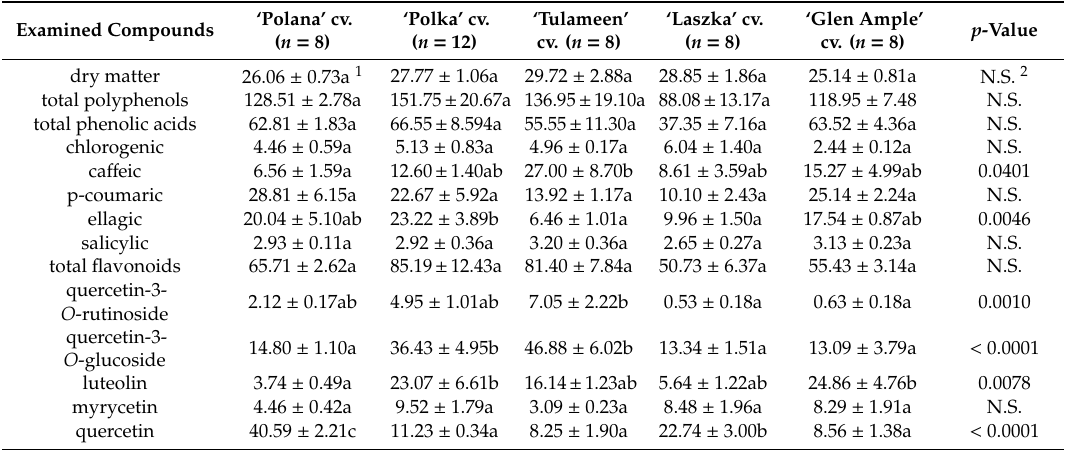
Table 3. The content of dry matter in (g 100 g − 1 FW) and polyphenols (mg 100 g − 1 FW) in examined raspberry leaves depending on cultivar. Data are presented as the mean ± SE with ANOVA p